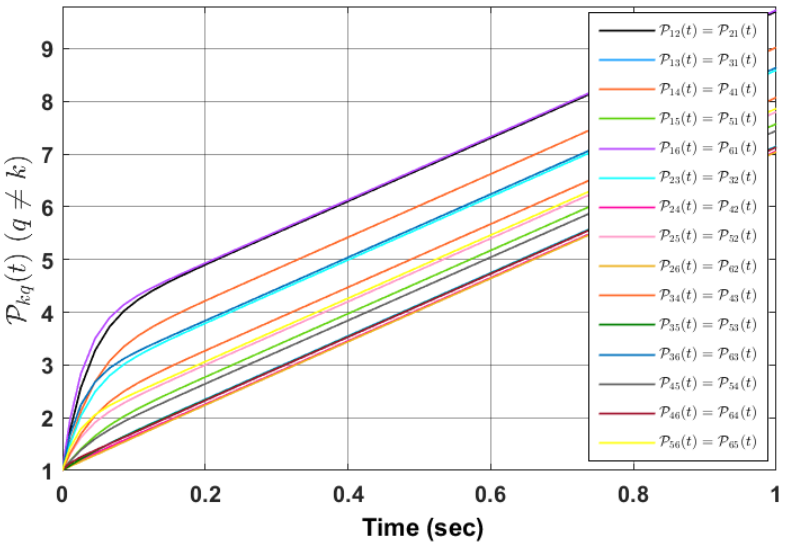
Figure 5. Evolution of P kq ( t ) with time.